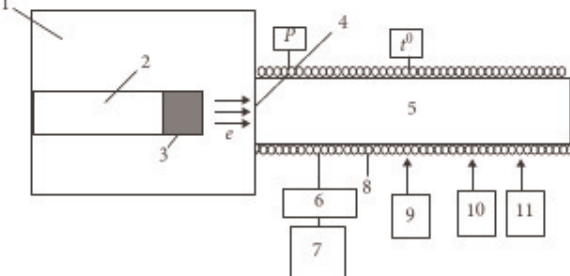
Figure 1: Scheme of experiment: diode chamber of the TEA-500 accelerator (1); cathode holder (2); cathode (graphite, 45mm di- ameter) (3); anode grid (3mm thick) (4); plasma-chemical reactor (PCR) (5); product collection system (6); high-pressure vacuum pump (7); PCR heating unit (8); oxygen cylinder (9); hydrogen cylinder (10); SiCl 4 dispenser (11).